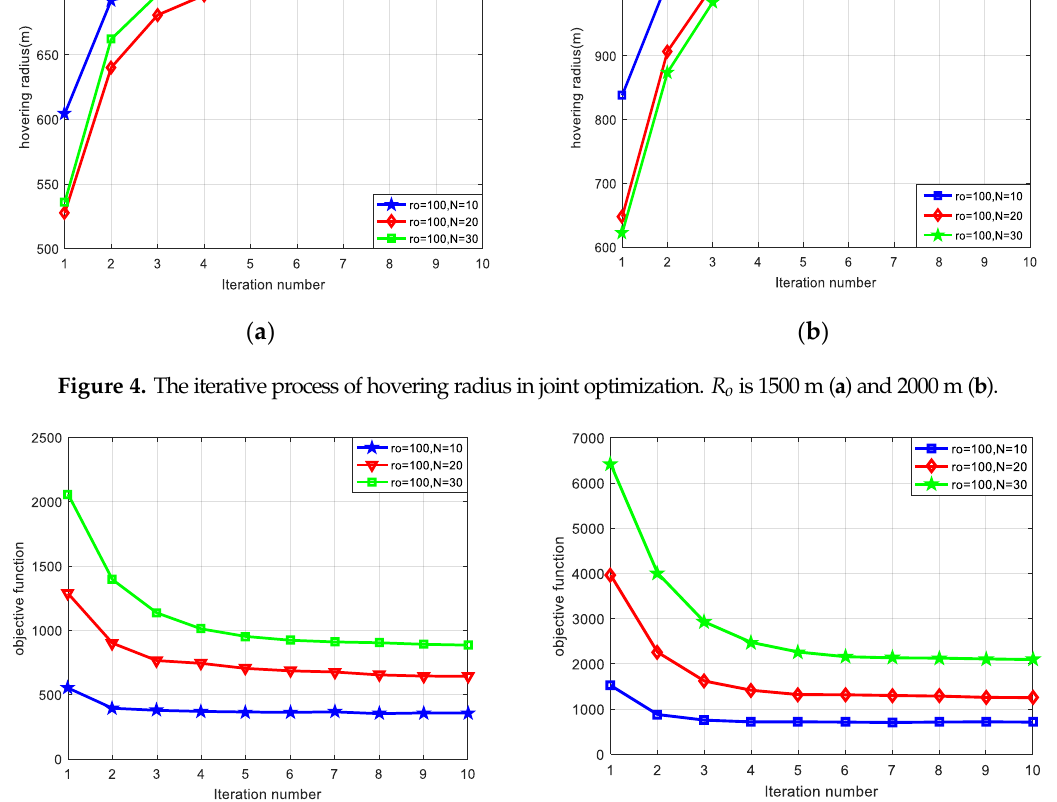
R is 1500 m(a) and 2000 m(b).